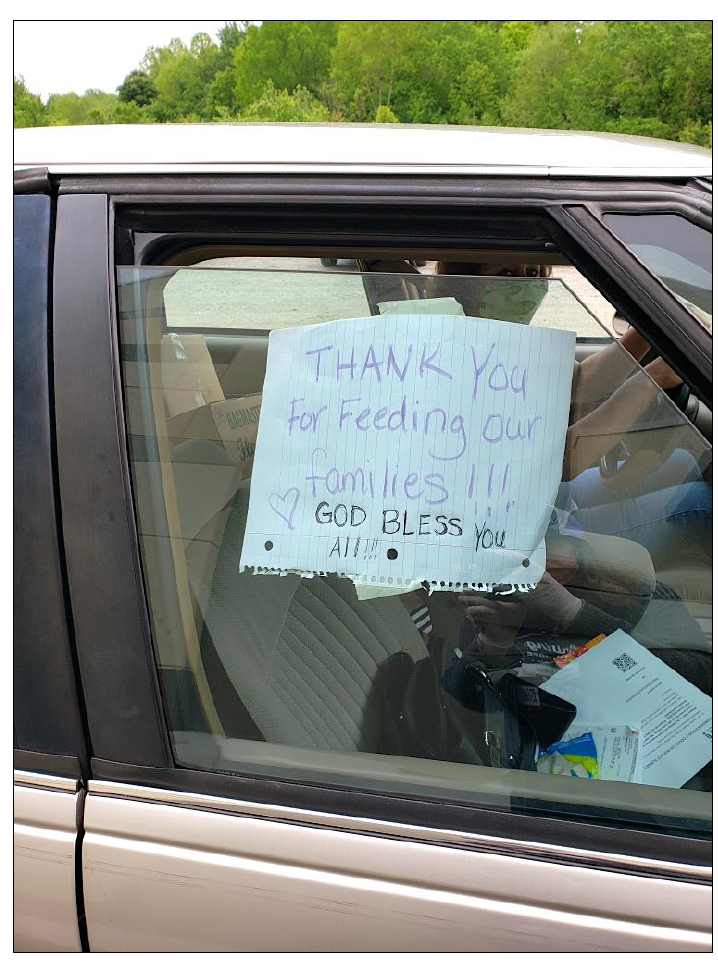
Figure 2. One of Many Notes of Gratitude Shared by a Food-Aid Seeker during a Food